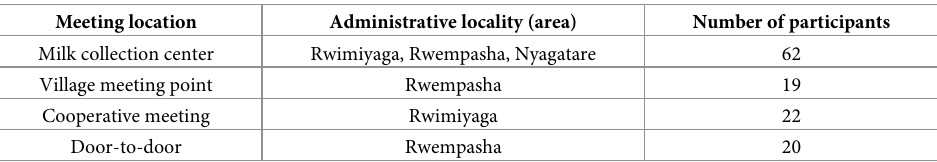
Table 1. Number of participants interviewed at each meeting